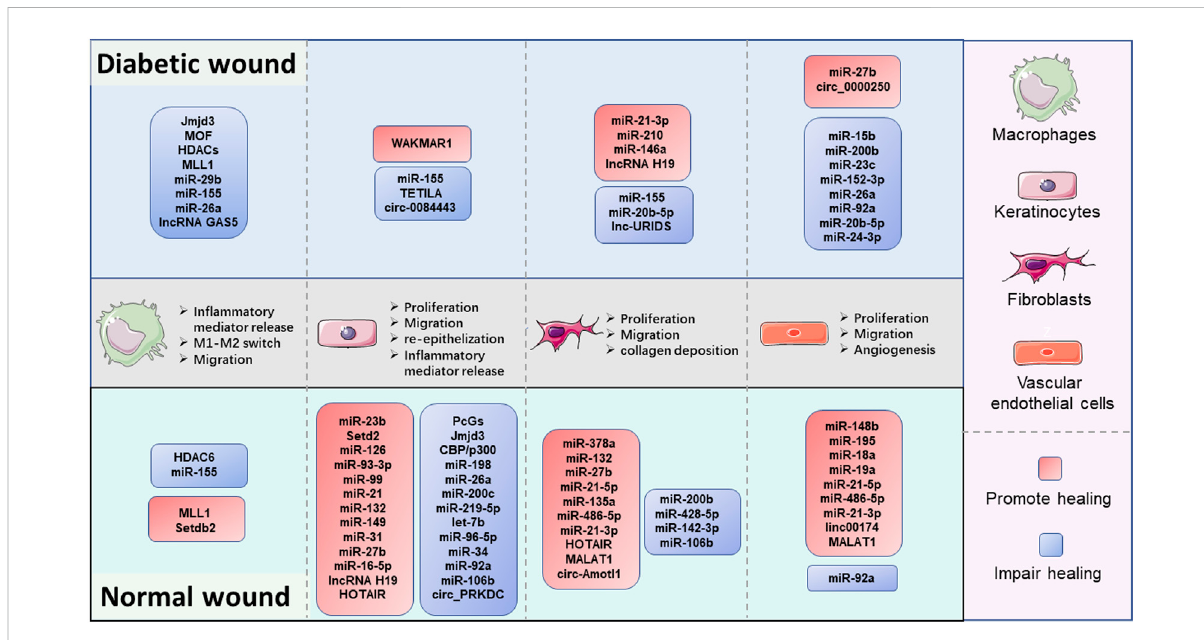
FIGURE 3 The comparison of epigenetic regulation in pivotal cellular components during the diabetic and normal wound healing process. Macrophages, keratinocytes, fi broblasts, and vascular endothelial cells are the major cellular components in wound repair. Fundamentally, DNA methylation and histone modi fi cation mainly regulate the cell function of macrophages, keratinocytes, and non-coding RNA mediate the function regulation of all four types of cells. Epigenetic changes can regulate the secretion of in fl ammatory factors, M1-M2 switch, and migration in macrophages. Besides, the epigenetic modi fi cations also affect the proliferation migration abilities of keratinocytes, fi broblasts, and vascular endothelial cells to promote or impair the re-epithelialization, collagen deposition, and angiogenesis processes in wound